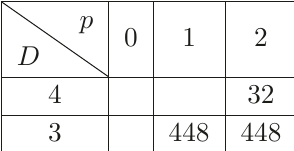
Table 6 . The G 9 , 6 (IIA) or G 9 , 6 , 1 (IIB) family of